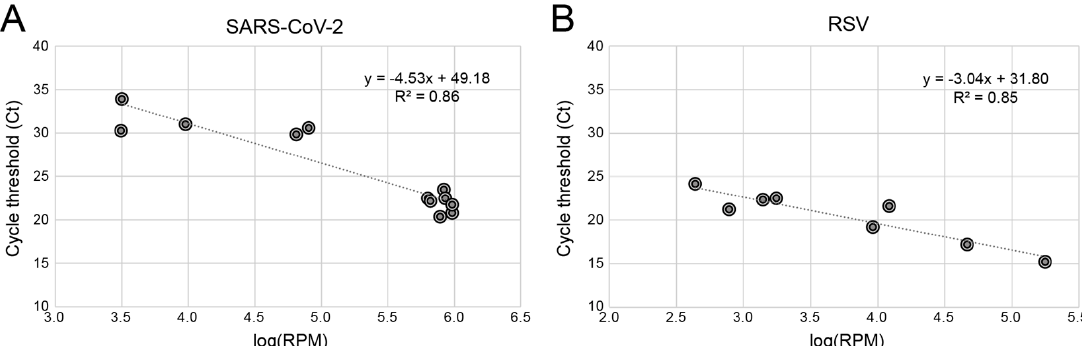
Figure 3. Quantitative detection of SARS-COV-2 and RSV sequences. A simple linear-regression model was applied to both SARS-CoV-2 ( A ) and RSV ( B ) data sets with a line of best fit estimating the relationship between log-transformed reads per million ( log RPM) and cycle threshold (CT) values. The linear-regression slope coefficient and the intercept parameter are printed on the top right of each plot, with R 2 calculated to measure the goodness of fi t. Table 4. Log-transformed reads per million ( log RPM) virus distribution across RAPID prep samples, with red shading indicating greater read depth as per the key provided at the bo tt om of the table.